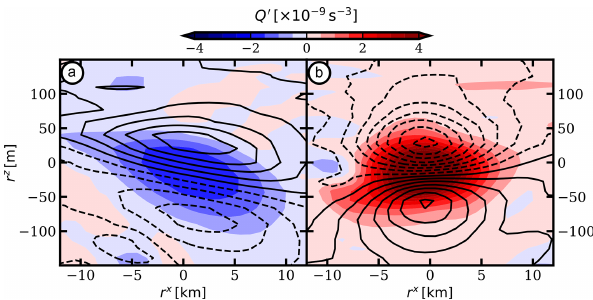
Figure 7. Vertical sections of potential vorticity anomaly for (a) an anticyclonic and (b) a cyclonic submesoscale eddy generated due to frictional effect (BBL experiment). Density anomalies associated with submesoscale eddies are shown in black